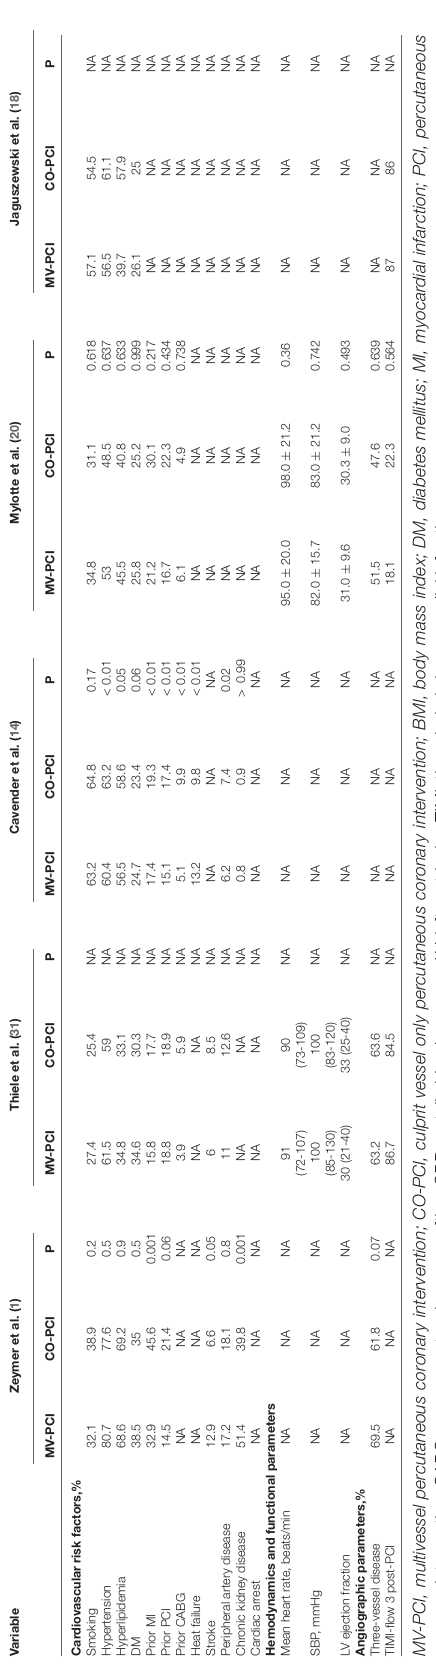
Figure 12 ; Egger’s test: p = 0.281) and stroke ( Supplementary Figure 13 ; Egger’s test: p =